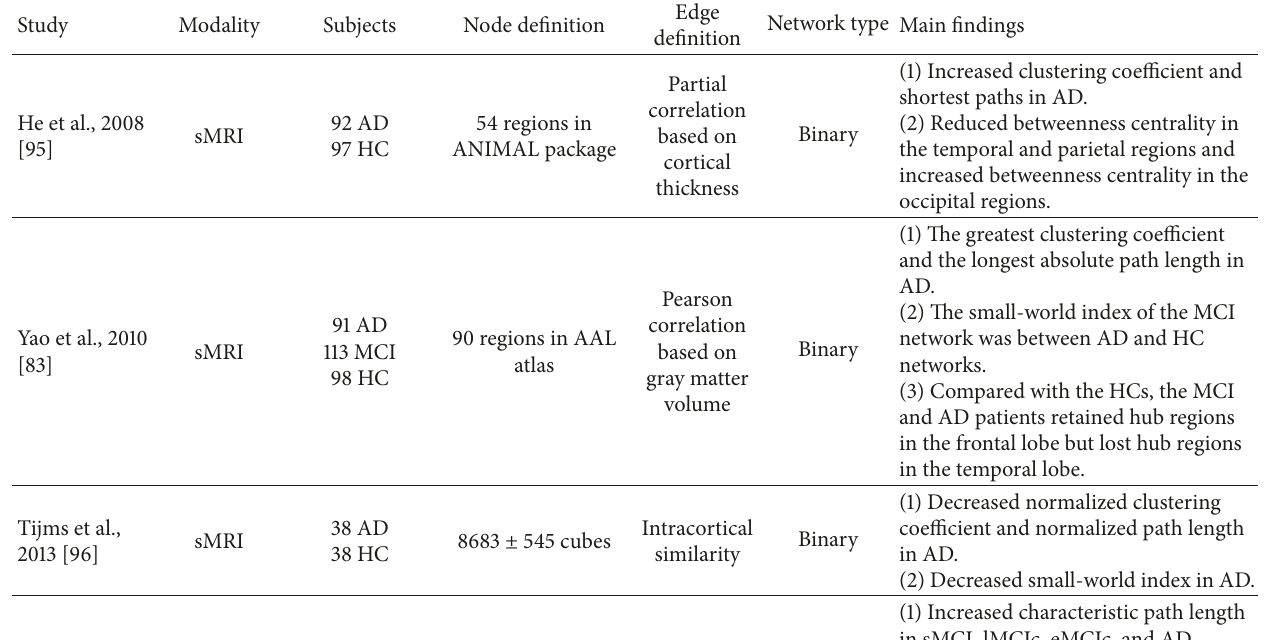
Table 2: Overview of structural brain network studies in